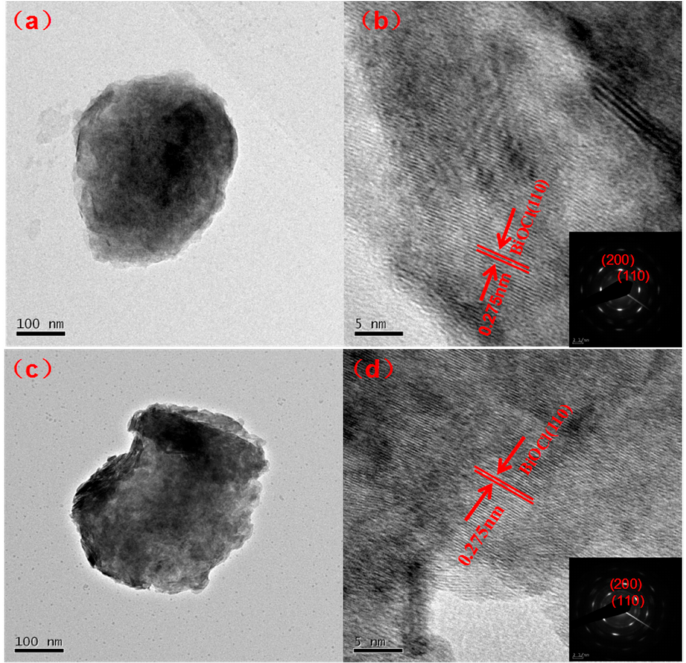
Figure 6. TEM images of BiOCl ( a ), 2% Dy doped BiOCl ( c ) and corresponding HRTEM ( b , d ); Inset: SAED pattern of the BiOCl and 2% Dy-doped